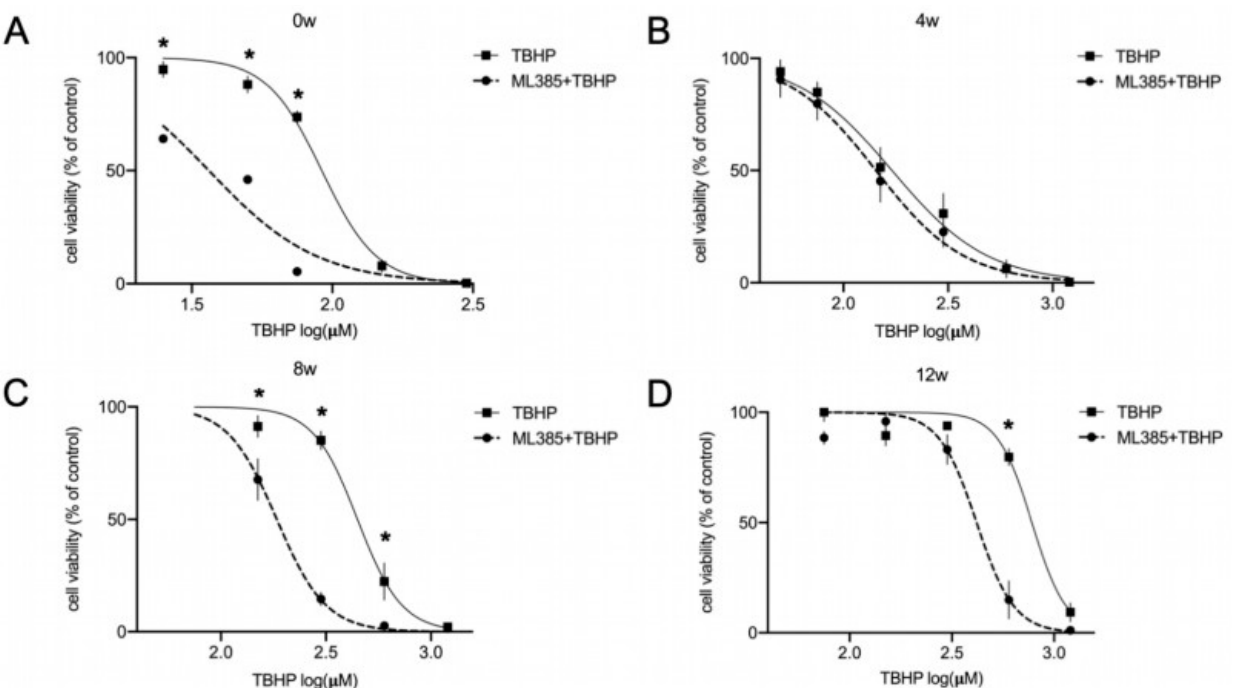
Figure 3. NRF2-KEAP1 signaling contributes to increased resistance to oxidative stress during differentiation of lt-NES cells. ( A – D ) Contribution of the NRF2 pathway to the OS response in differentiating lt-NES cultures was assessed using the NRF2 inhibitor ML385. Cell viability in response to oxidative stress was assessed in undifferentiated lt-NES cells ( A ) and lt-NES cells differentiated for 4 ( B ), 8 ( C ) and 12 ( D ) weeks after 24 h pre-treatment with ML385 followed by 24 h tert-butyl hydroperoxide (TBHP) treatment. Toxicity was assessed by ATPlite assay at the end of the treatment period with the indicated concentrations. Data are presented as means ± SEM ( n ≥ 3, consisting of at least 4 technical replicates each). Significant difference between TBHP treatments with or without ML385 was confirmed by two-way ANOVA (Interaction p values: 0 w p < 0.0001; 4 w p = 0.9990; 8 w p < 0.0001; 12 w p < 0.0001) followed by Sidak’s multiple comparisons test (* = p <